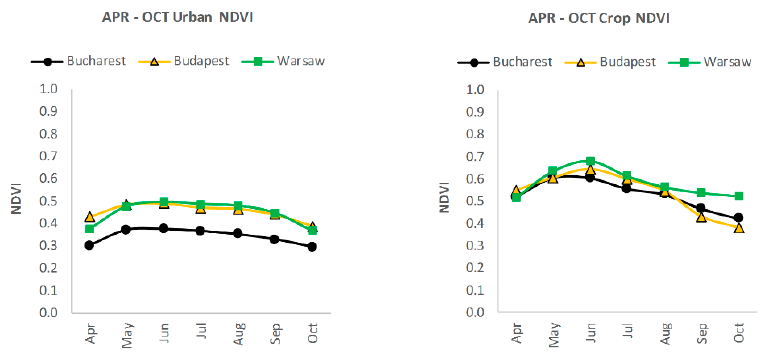
Figure 4. Average normalized difference vegetation index (NDVI) for urban ( left ) and cropland ( right ) classes for the three study cities.